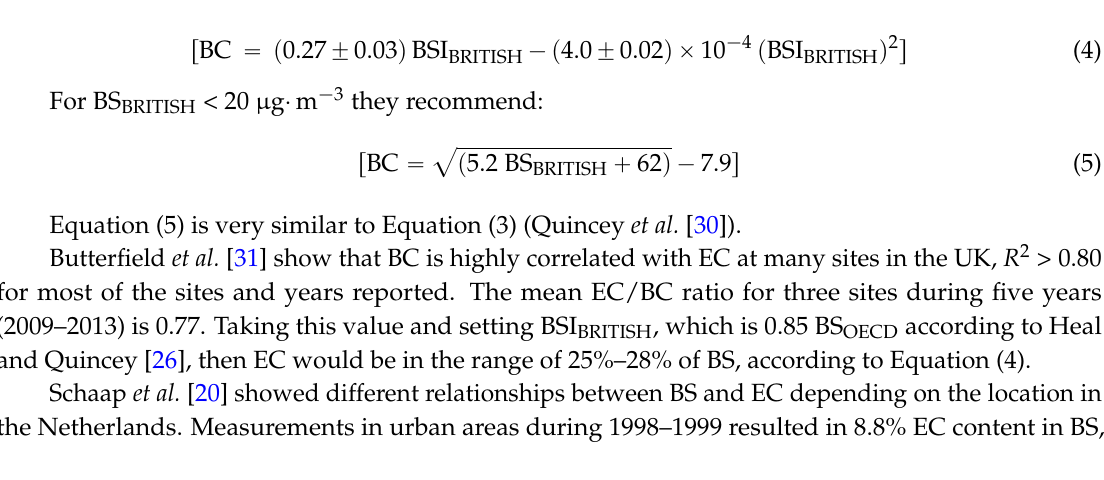
Figure 2. The ratio of relative increase in all-cause mortality associated with short-term exposure to measured levels of PM 10 vs. exposure to our calculated concentrations of EC, derived from measured